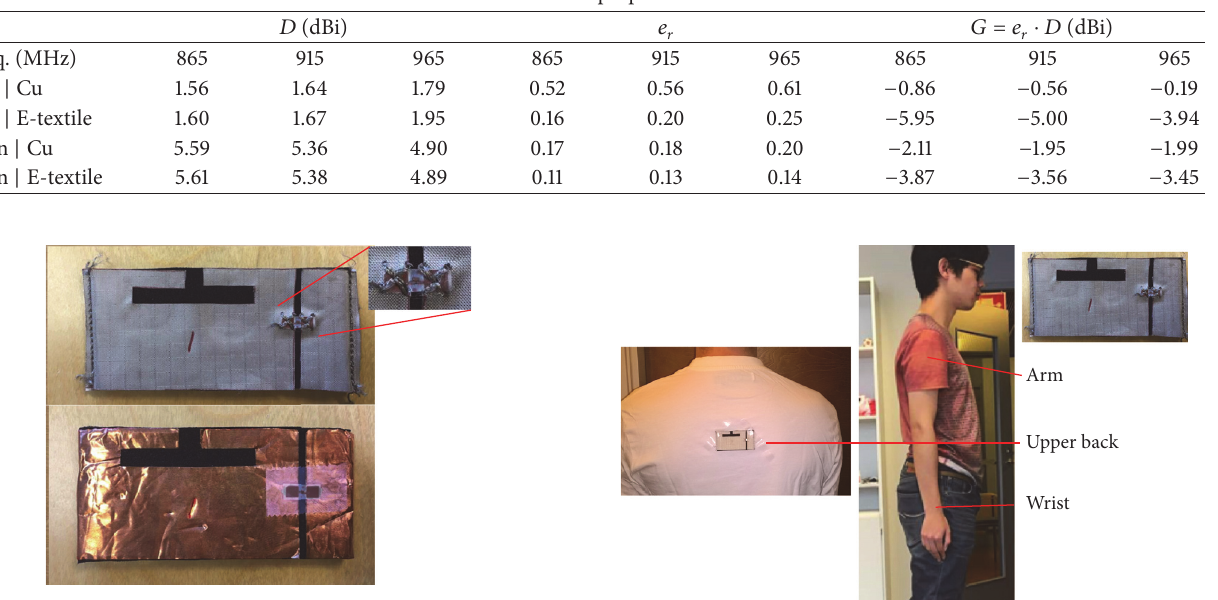
Figure 5: Samples of the manufactured e-textile (top) and copper tape (bottom) tags.